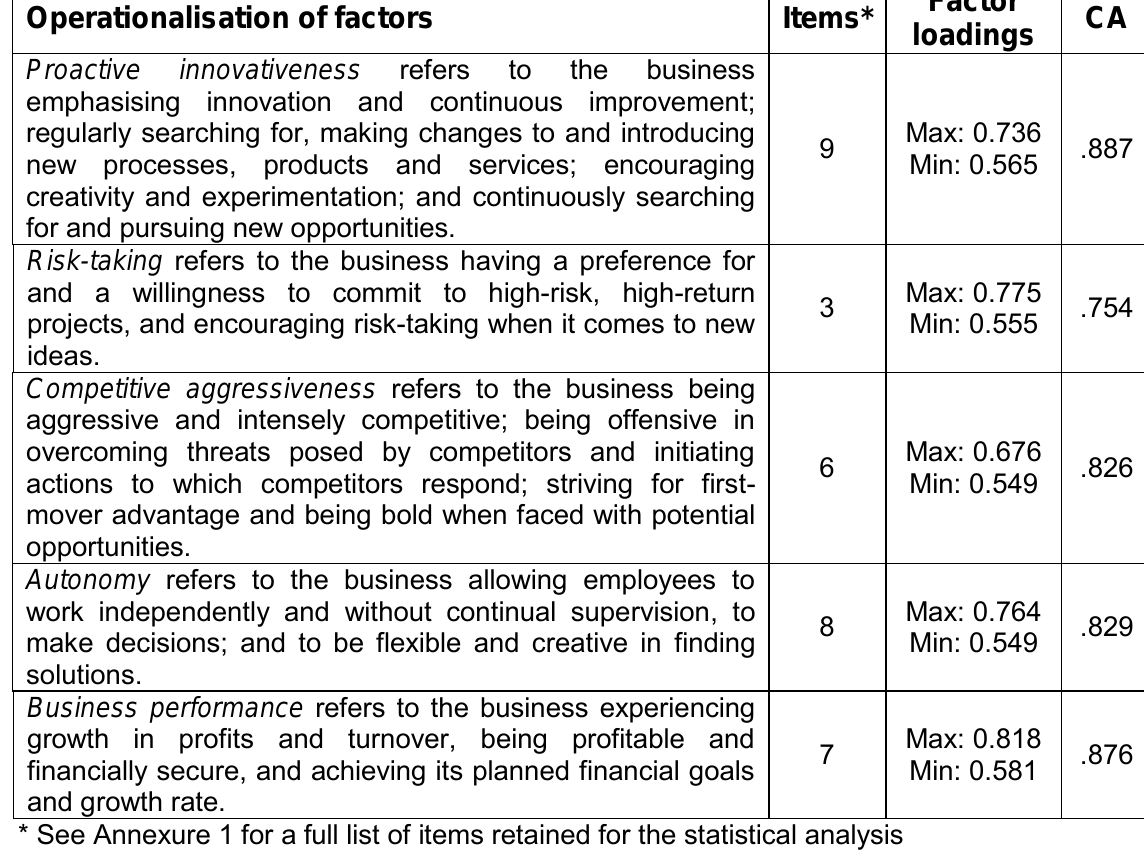
TABLE 1 OPERATIONAL DEFINITIONS AND VALIDITY AND RELIABILITY OF RESULTS Operationalisation of factors Items* Proactive innovativeness refers to the business emphasising innovation and continuous improvement; regularly searching for, making changes to and introducing new processes, products and services;